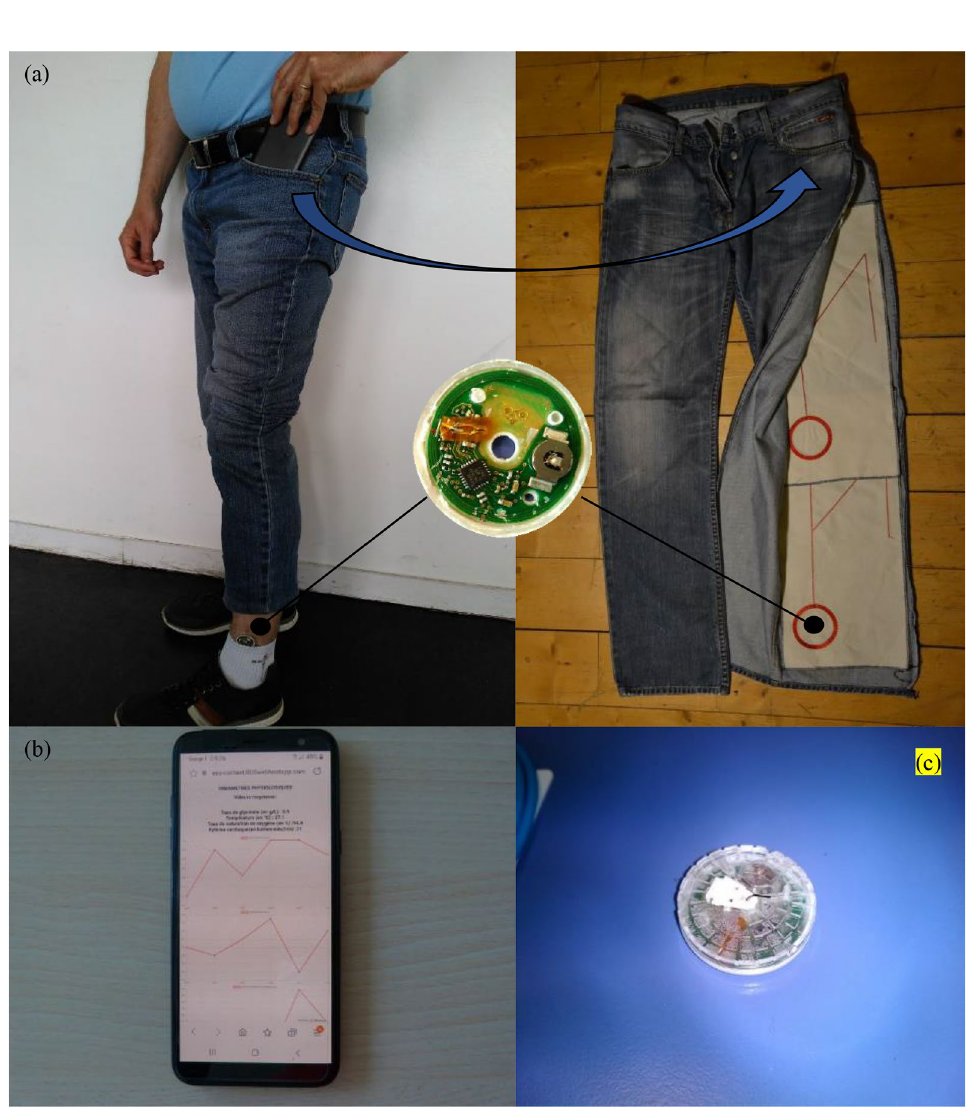
Figure 7. ( a ) The textile dual-band near field multiple combiner proof of concept, ( b ) the data transmitted and ( c ) the